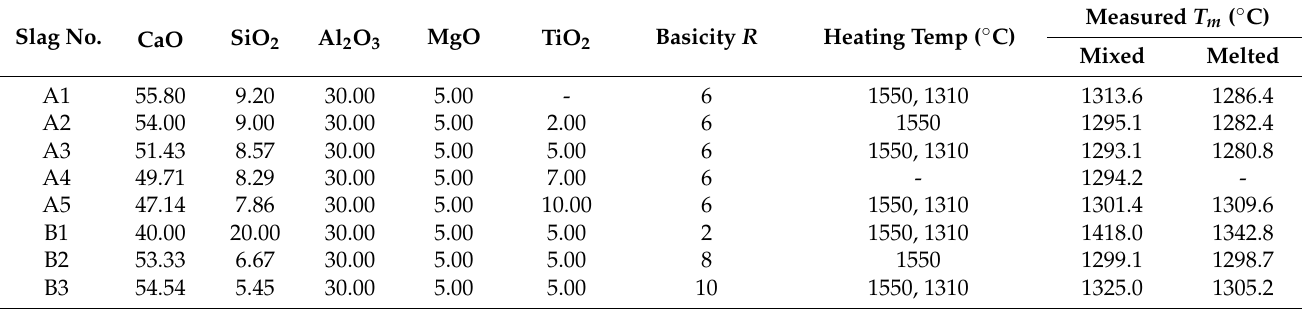
Table 1. Compositions (mass%) and measured melting points ( T m , ◦